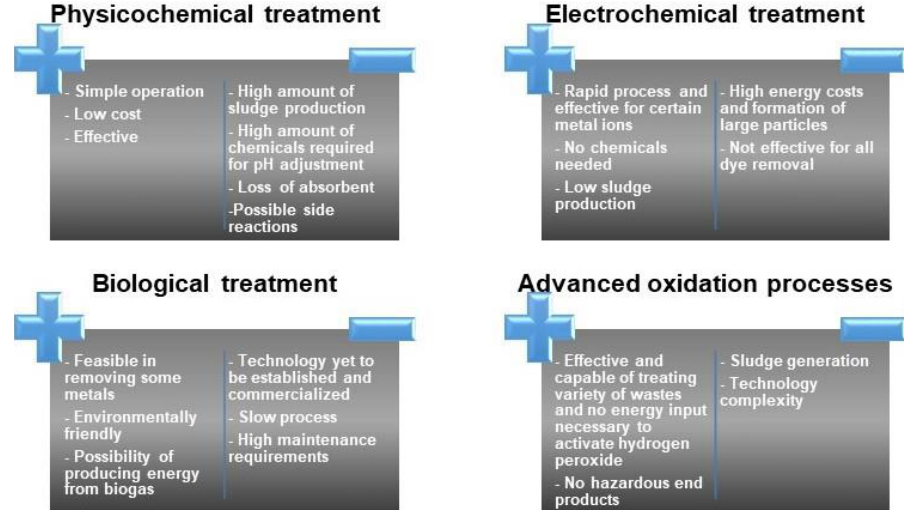
Figure 6. The main advantages and disadvantages of paint industrial wastewater treatment methods.